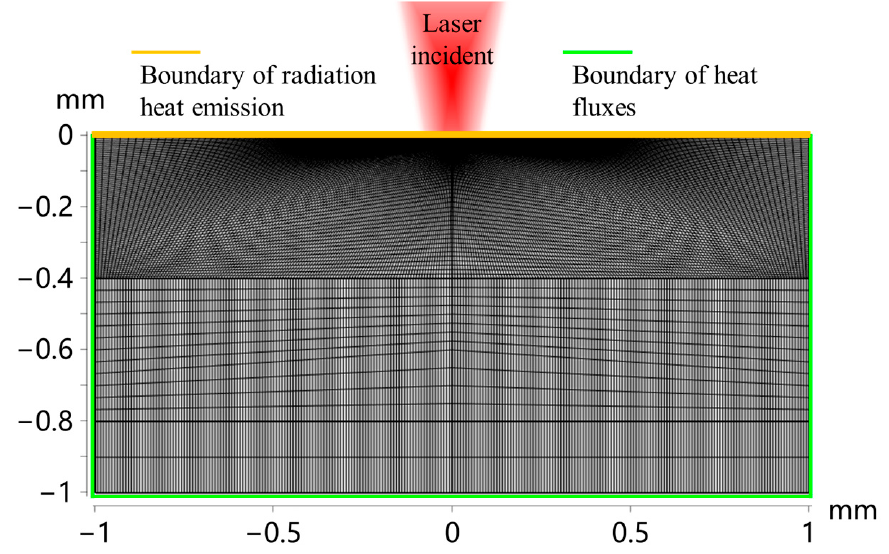
Figure 4. Two-dimensional numerical model for simulation calculations.